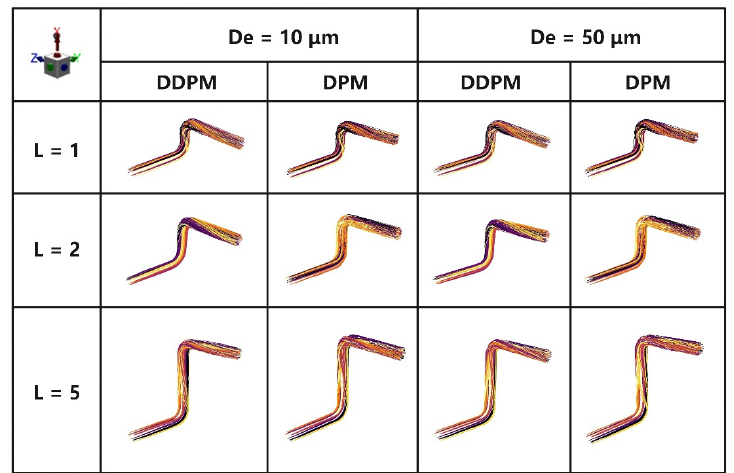
Figure 9. Particle trajectories calculated by the DDPM and the DPM.